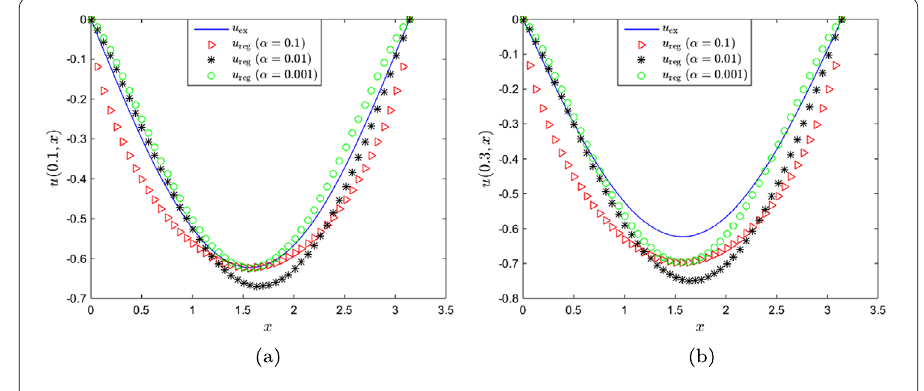
Figure 1 The exact and regularized solutions at y = 0.1 ( a ) and y = 0.3 ( b ) for α ∈ { 10 –1 ,10 –2 ,10 –3 }